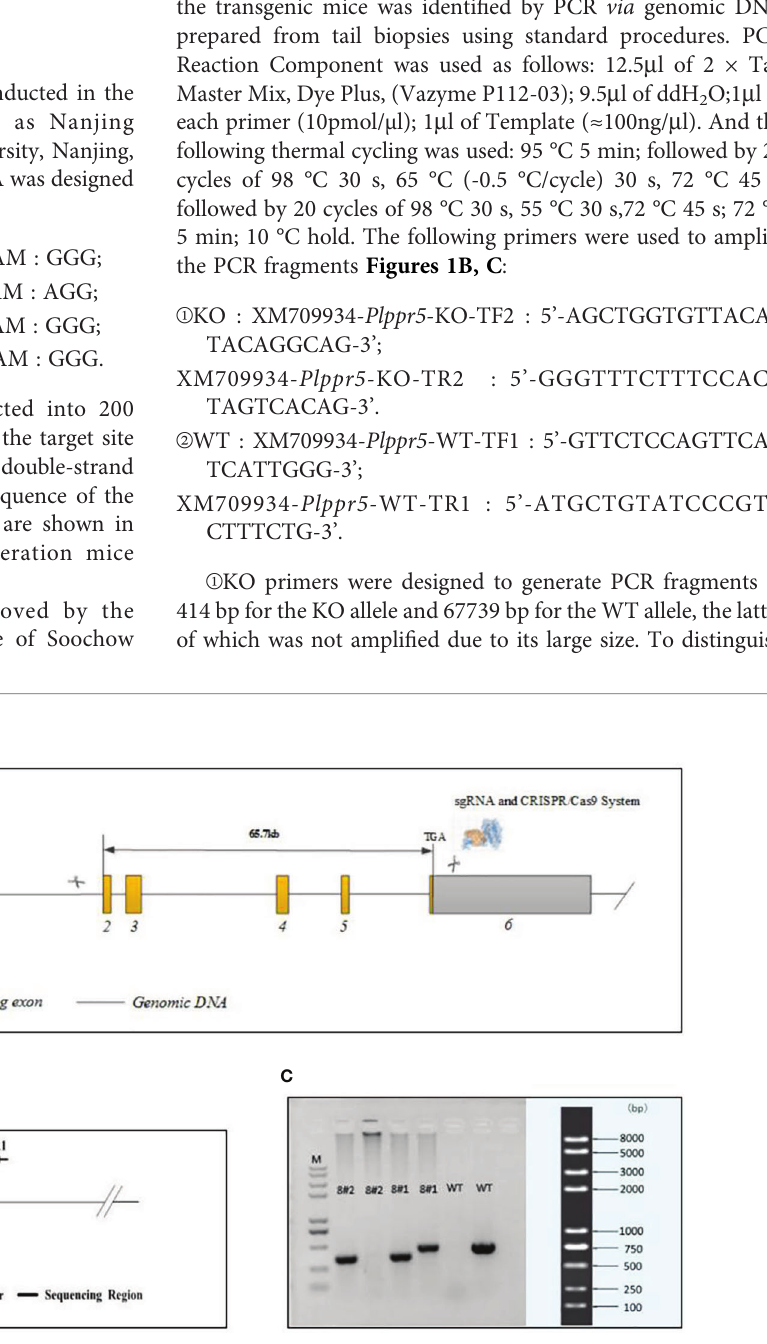
FIGURE 1 | Generation of plppr5 − / − mice and con fi rmation of plppr5 de fi ciency at the DNA level. (A) Gene sequence insertion; (B) PCR analysis; (C) Samples 8#2 and 8#1 correspond to the plppr 5 − / − and plppr 5+/- mice, respectively. M represents the DNA